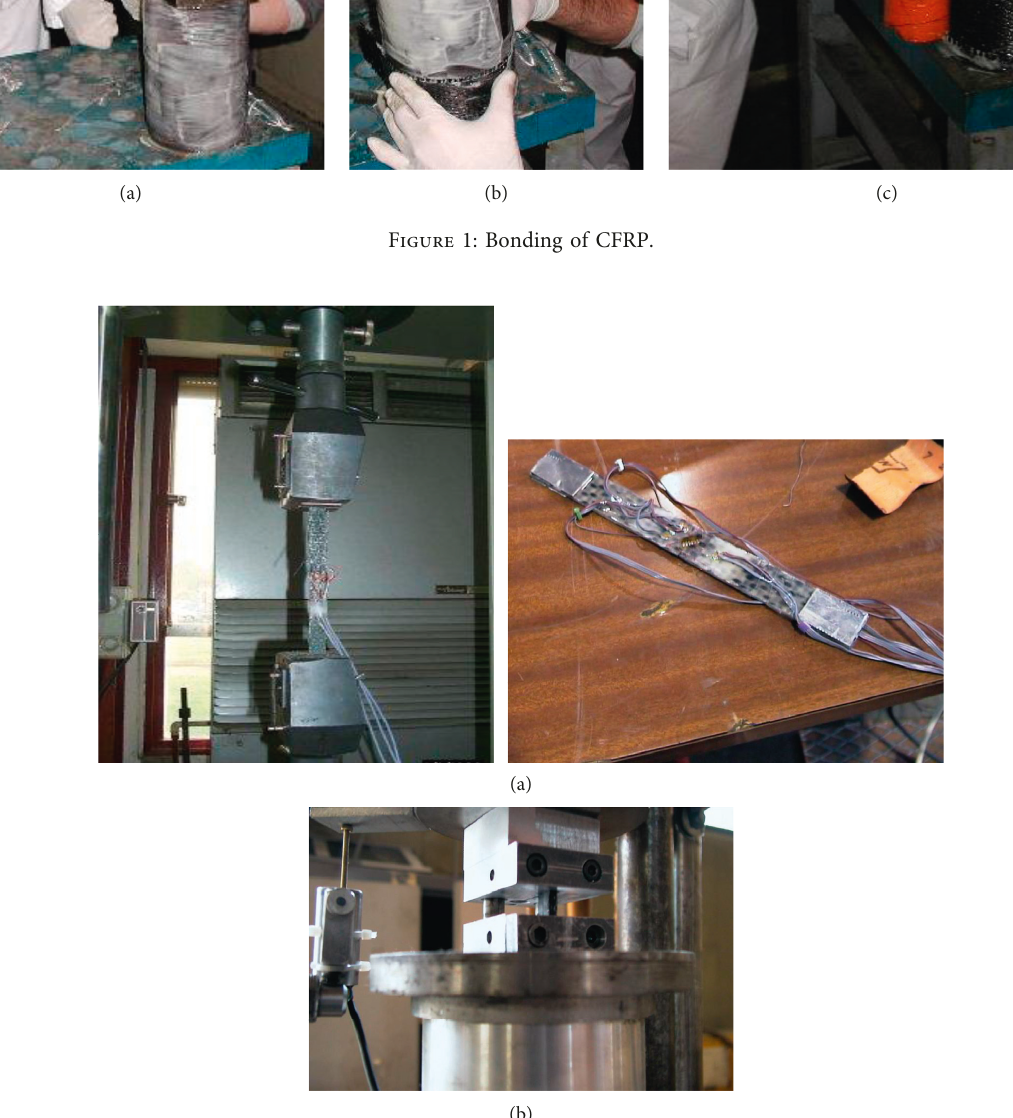
Figure 2: (a) Tension: test setup and specimen; (b) compression: test